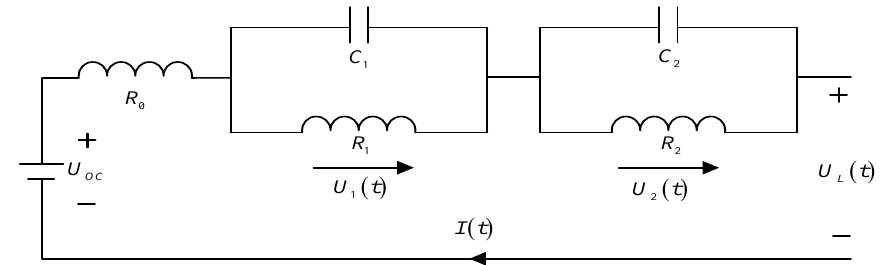
Figure 1. Second-order RC equivalent circuit model. Where U OC represents open-circuit voltage, R 0 is battery ohm internal resistance, C 1 , C 2 is polarized capacitance, R 1 , R 2 is polarized resistance, U L ( t ) is circuit end voltage, I is load current. Current end voltage U ( t ) and circuit current I can be measured by the